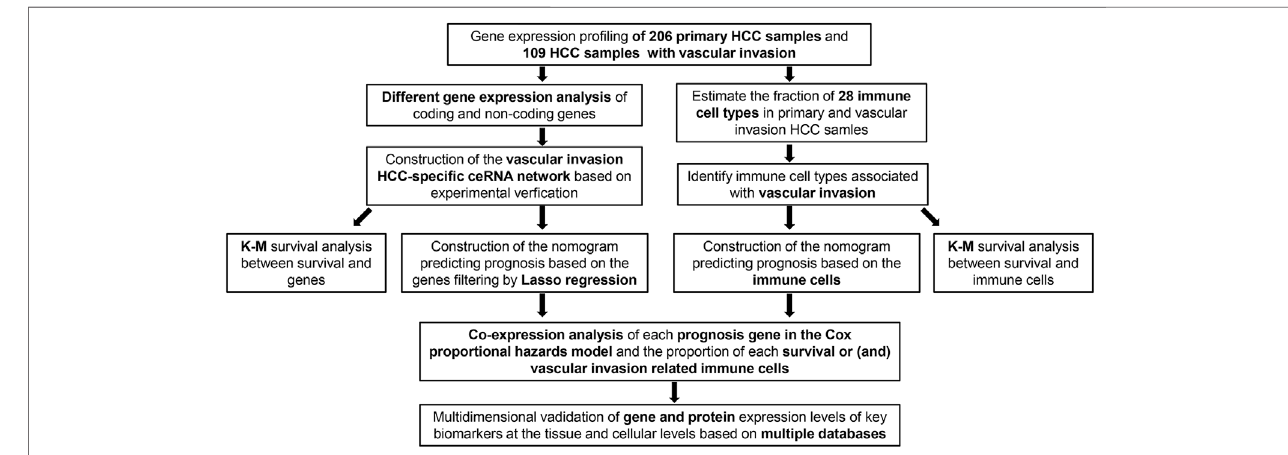
FIGURE 1 | Flowchart of the analysis